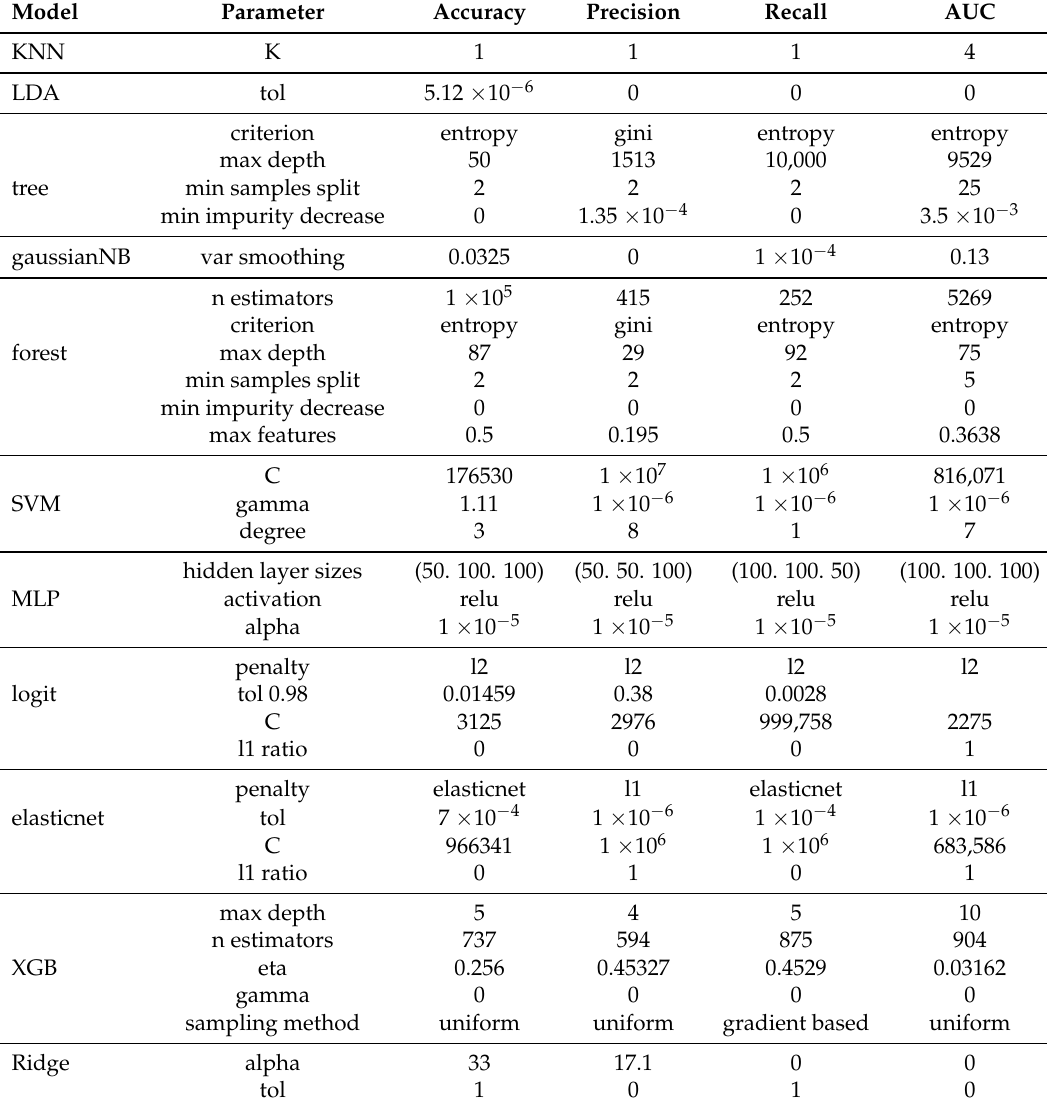
Table A2. Optimal hyper-parameters for 1-month injury